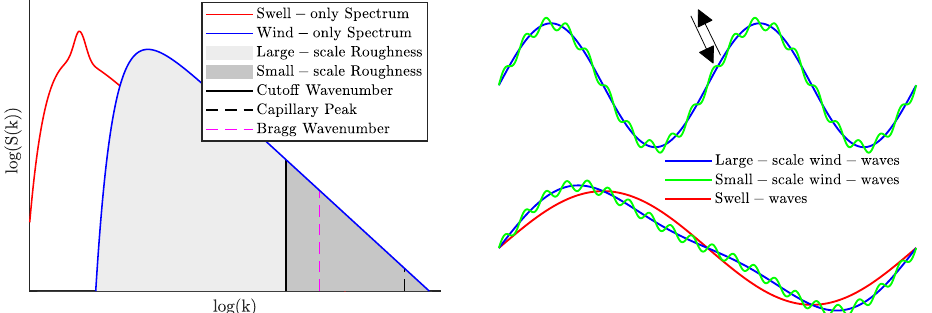
Figure 2. Notional ocean spectrum and resulting ocean waves. The ( left ) panel compares wind- only (blue) and swell-only (red) wave spectra. The wind-only spectrum is divided along the cutoff wavenumber k c to distinguish large- and small-scale roughness contributions. The Bragg and capillary wavenumbers are also shown for reference. The ( right ) panel shows notional wind waves ( top ) and wind and swell waves ( bottom ), while arrows indicate incident and backscattered EM